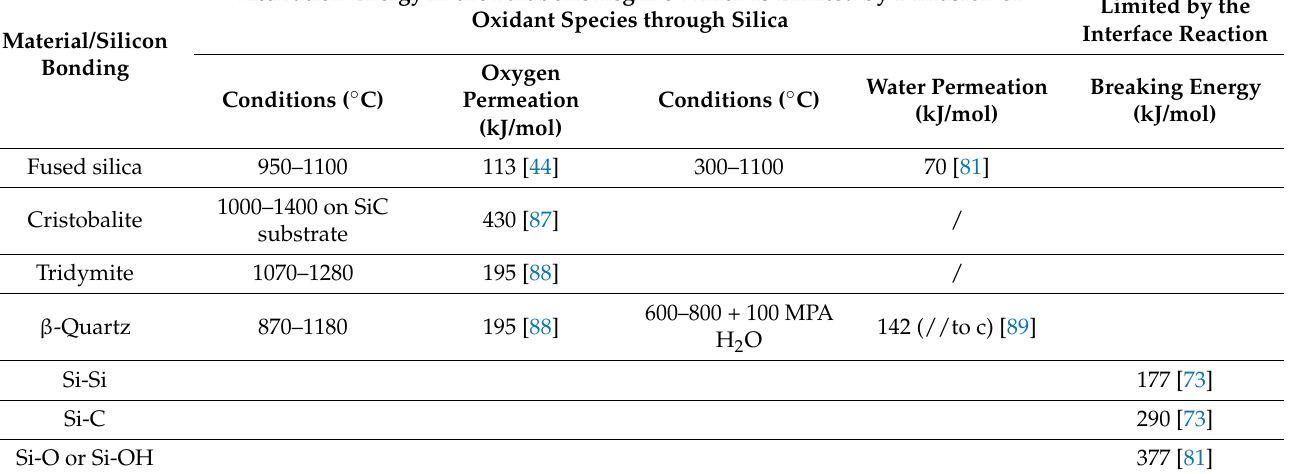
Table 6. Activation energy for water and oxygen molecules through silica and silicon-containing bond energies.